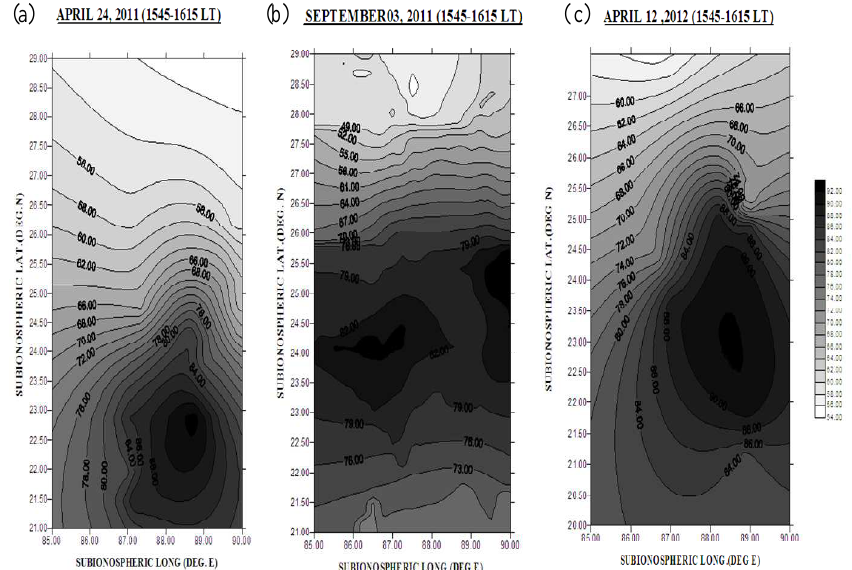
Fig. 3. (a–c) Contours of measured VTEC at 10:00UT ( ∼ 16:00LT) on 3 days 24 April 2011, 3 September 2011 and 24 April 2012 at different subionospheric longitudes and latitudes ranging from 85 ◦ E to 90 ◦ E and 20 ◦ N to 29 ◦ N (except 12 April 2012), respectively, and for 12 April 2012 subionospheric latitude ranges from 20 ◦ N to 27 ◦